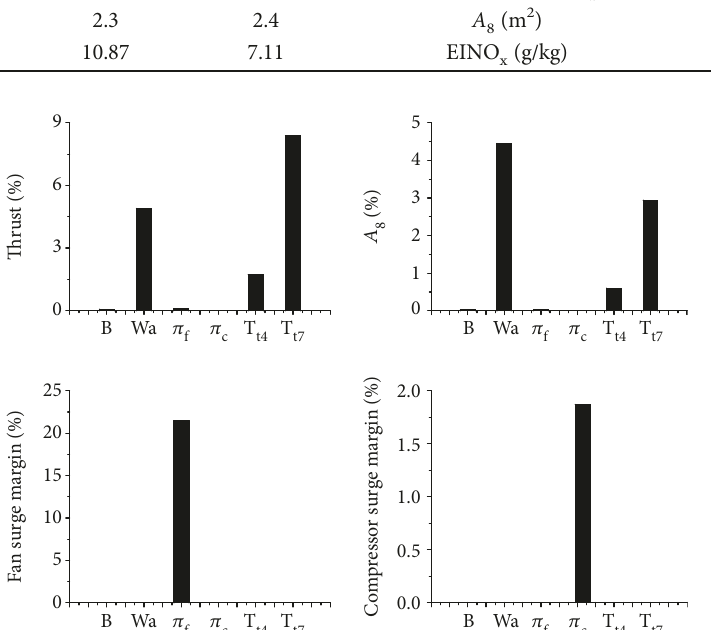
Figure 22: Sensitivity analysis of the mode transition point (design point of the turbofan